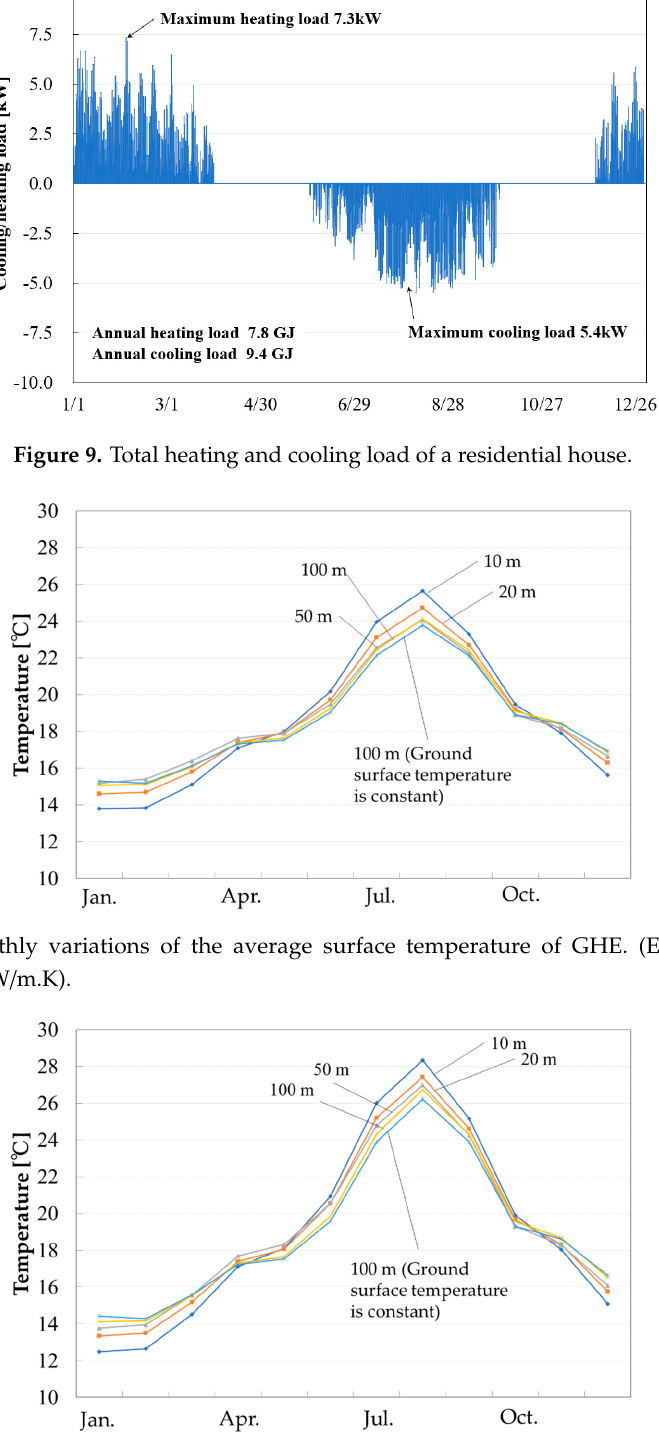
Figure 11. Monthly variations of the average surface temperature of GHE. (Effective thermal conductivity 1.0 W/m.K).